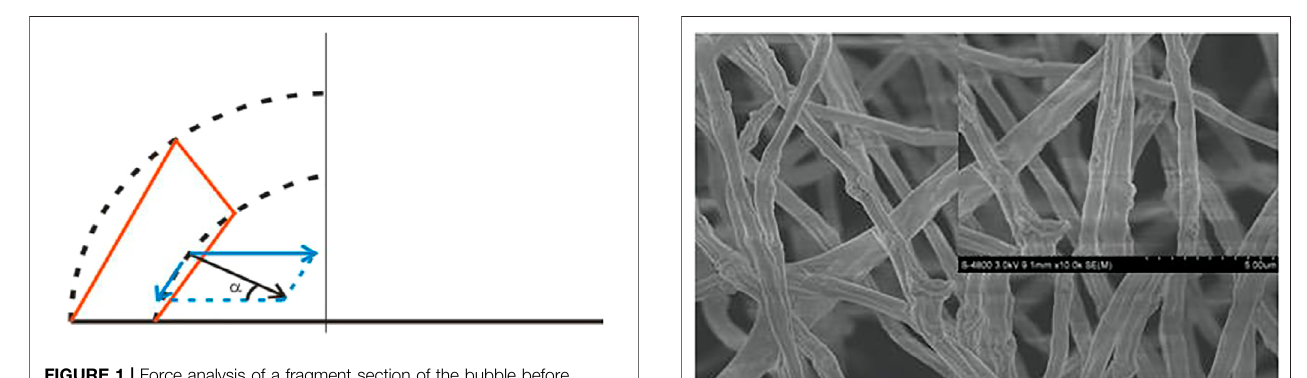
FIGURE 1 | Force analysis of a fragment section of the bubble before rupture.